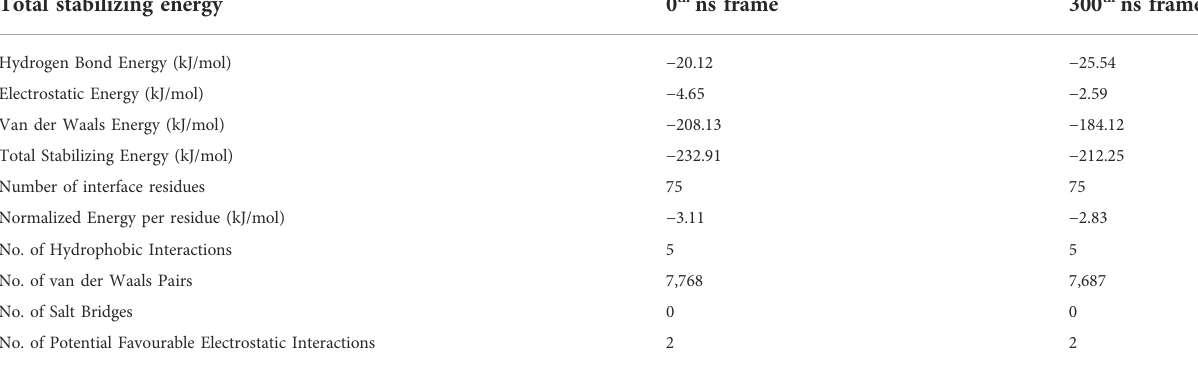
TABLE1Thetotal stabilizing energy at t=0 nsand t= 300 ns forthe disease relevant wild-type A β 1-42 fi bril (PDBID: 2NAO)interactingwith cyclotide Cter-M (PDB ID: 2LAM). Total stabilizing